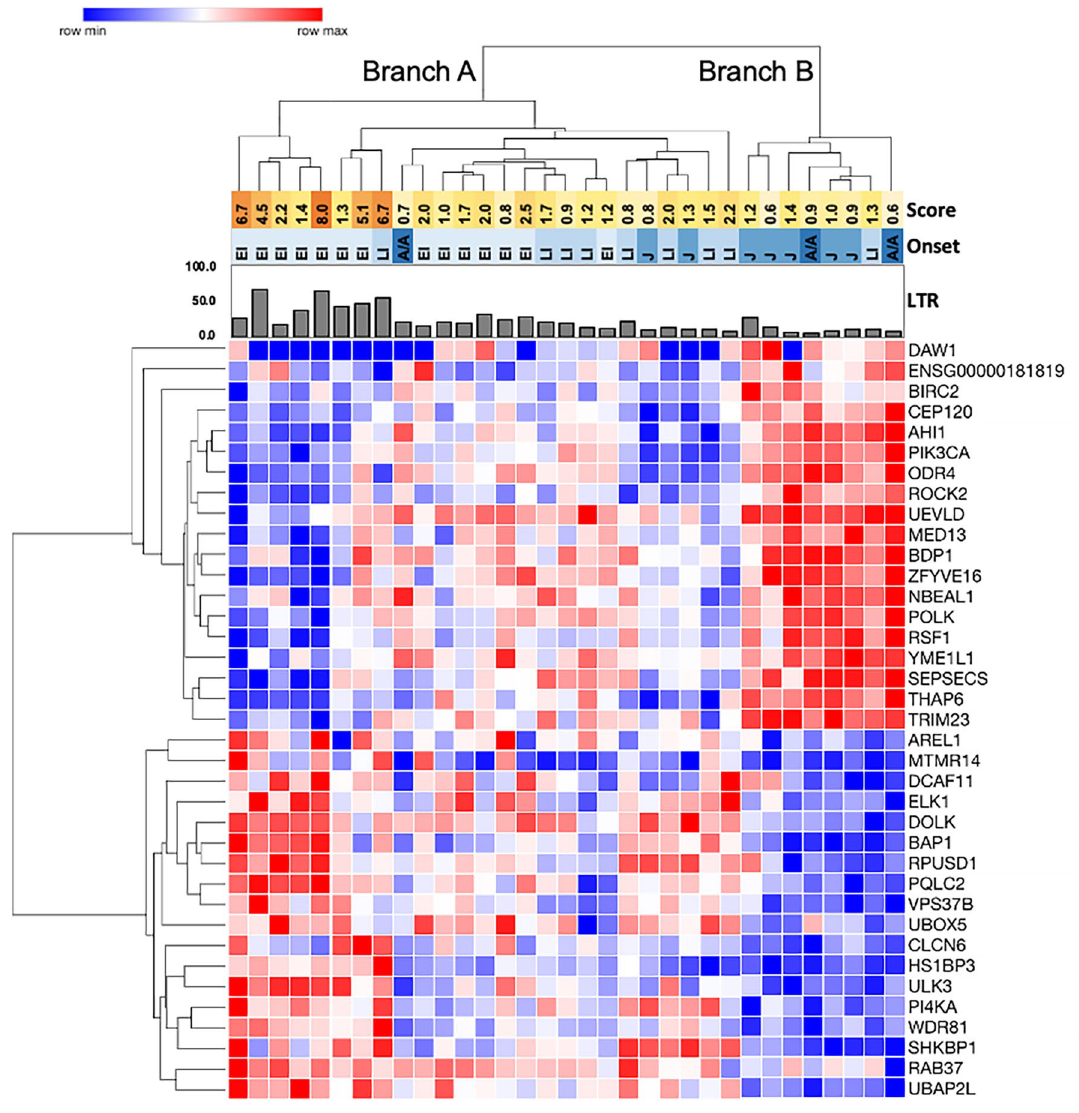
Figure 4. Genes correlated with age of first neurological symptom show distinct gene expression patterns among NPC1 patient subgroups. The heatmap shows hierarchical clustering of variance stabilized read counts of the 37 genes significantly correlated with the age of first neurological symptom. Patient cell lines (columns) were grouped into two high-order branches by clustering analysis, labeled Branch A and Branch B. Genes (rows) clustered into two branches, and the patient cell line Branches A and B show inverse expression of these two gene groups. Hierarchical clustering of all significantly correlated genes is shown in Supplementary Fig. 1. Score: neurological severity scores for each patient are shown in the yellow to orange heatmap, with darker colors indicating higher scores/greater severity. Onset: age of first neurological symptom is shown in the blue heatmap, with darker blues indicating older ages (EI = early infantile, LI = late infantile, J = juvenile, A/A = adolescent/ adult). The bar graph indicates LysoTracker levels (LTR) in untreated